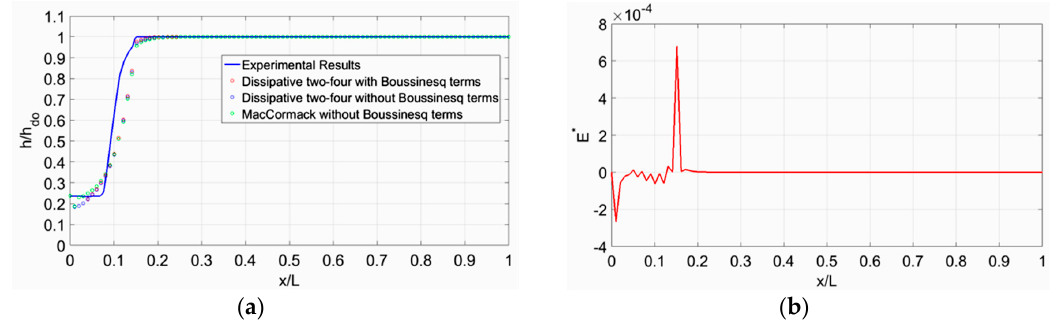
Figure 4. Experimental and Numerical Results for test case 3: ( a ) Free surface profile; ( b ) Boussinesq